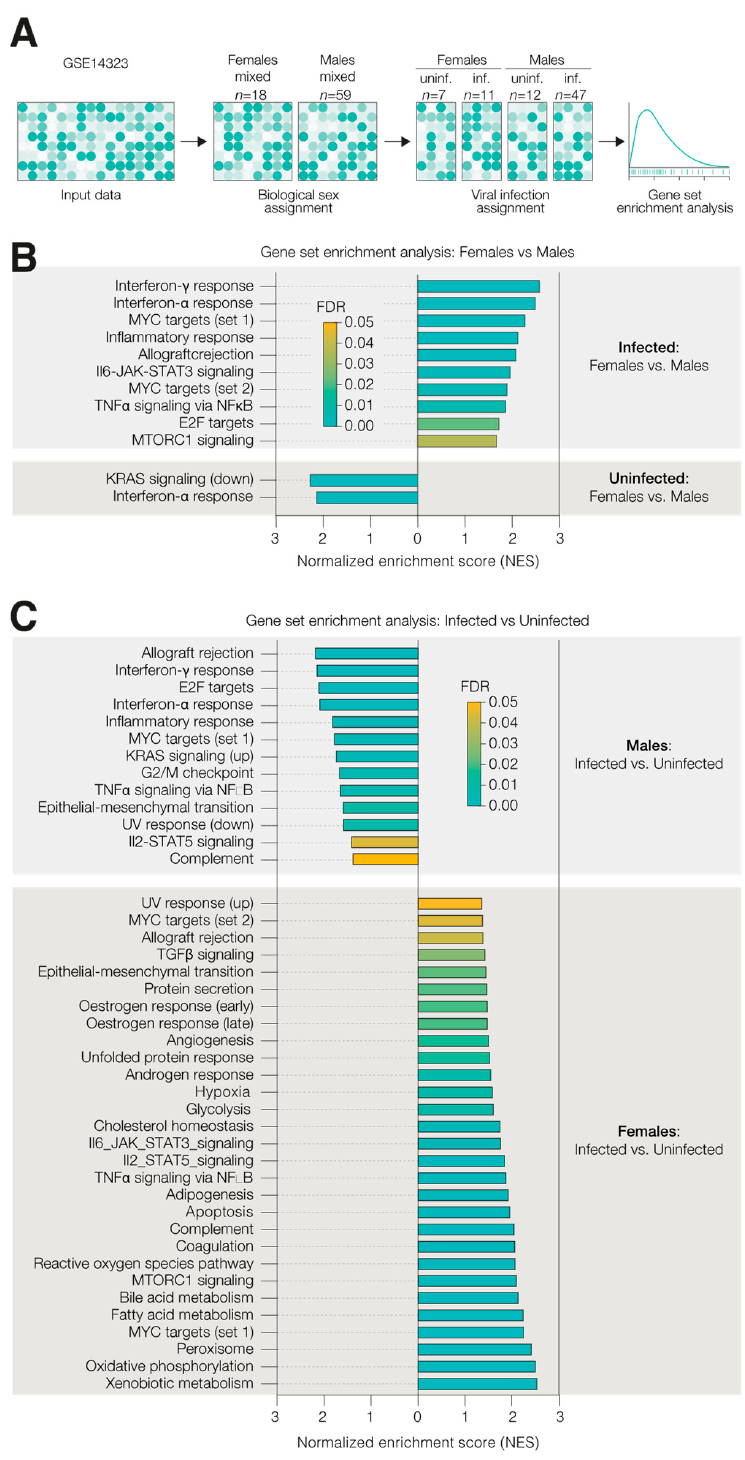
Figure 5. Biological sex confers endogenous innate immune protection. ( A ) Using GSEA, Affymetrix microarray data were interrogated to understand the impact of biological sex on host cell processes. ( B ) Hallmark gene set expression was assessed to show the sex-specific pathway enrichment in the presence ( top ) or absence ( bottom ) of HCV infection. Hallmarks showing significant enrichment in females are plotted, ranked by normalised enrichment score, and coloured based on FDR. ( C ) Separating patients by biological sex, we applied GSEA to understand the impact of viral infection on the hepatic transcriptome.